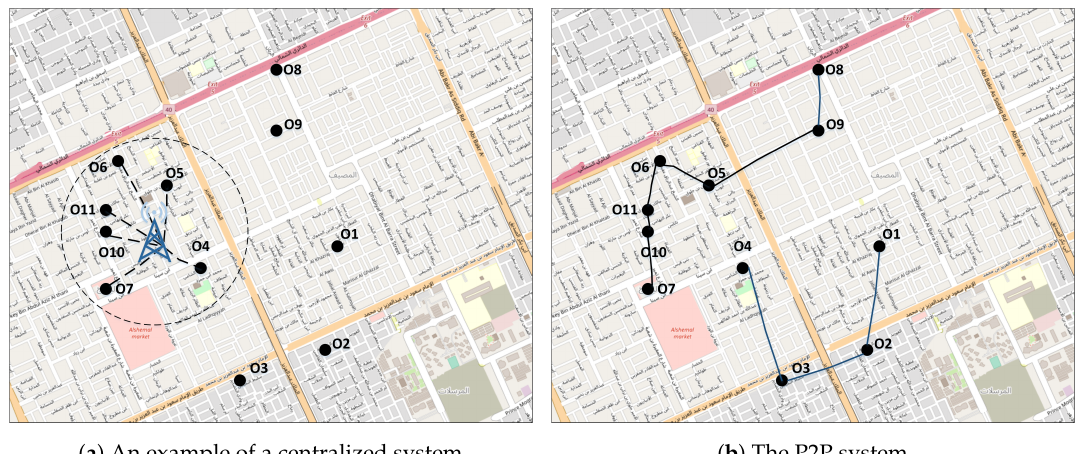
Figure 11. The centralized system and the P2P system.